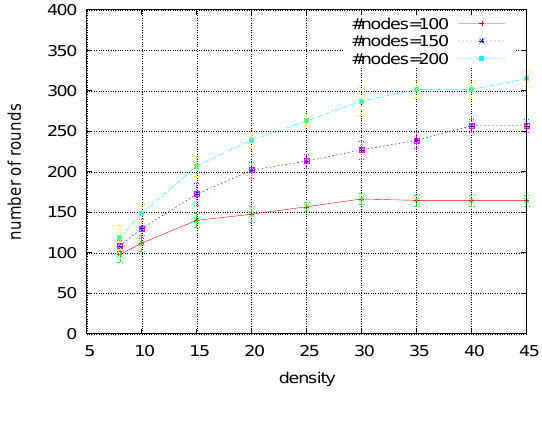
Fig. 7. Number of rounds for SERENA.